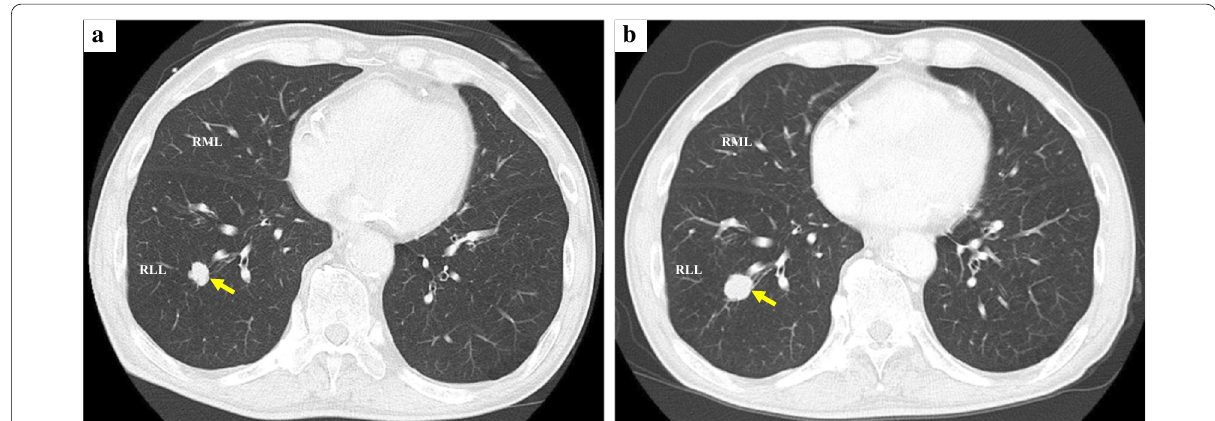
Fig. 1 Axial section of computed tomography findings. The tumor is located in S9 of the right lung (arrow). a Four months before lung resection. b One month before lung resection. RLL right lower lobe; RML right middle lobe